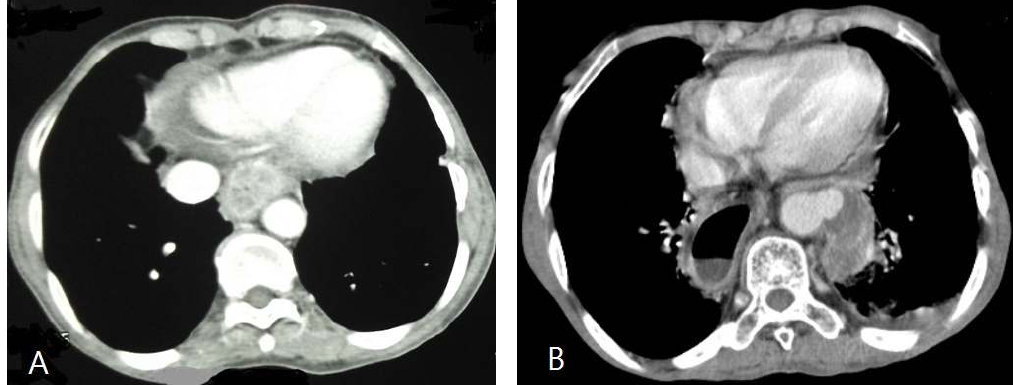
Figure 1 . A) Preoperative contrast-enhanced axial CT scan showing esophageal thickening and normal descending thoracic aorta. B) Postoperative contrast-enhanced axial CT scan showing a